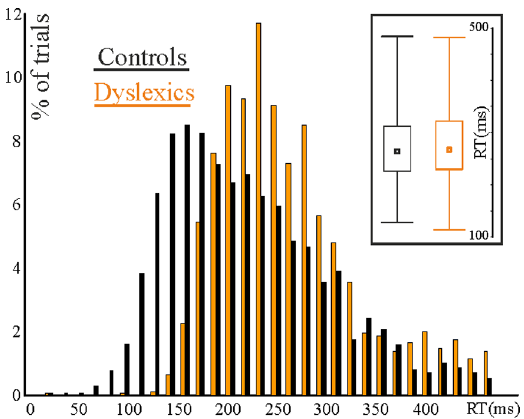
Figure 3. Distribution of Reaction Times (RTS) by group, 2 hz condition. Middle square indicates median RT; Box indicates the middle 75% of the distribution; Tails indicate min/max.